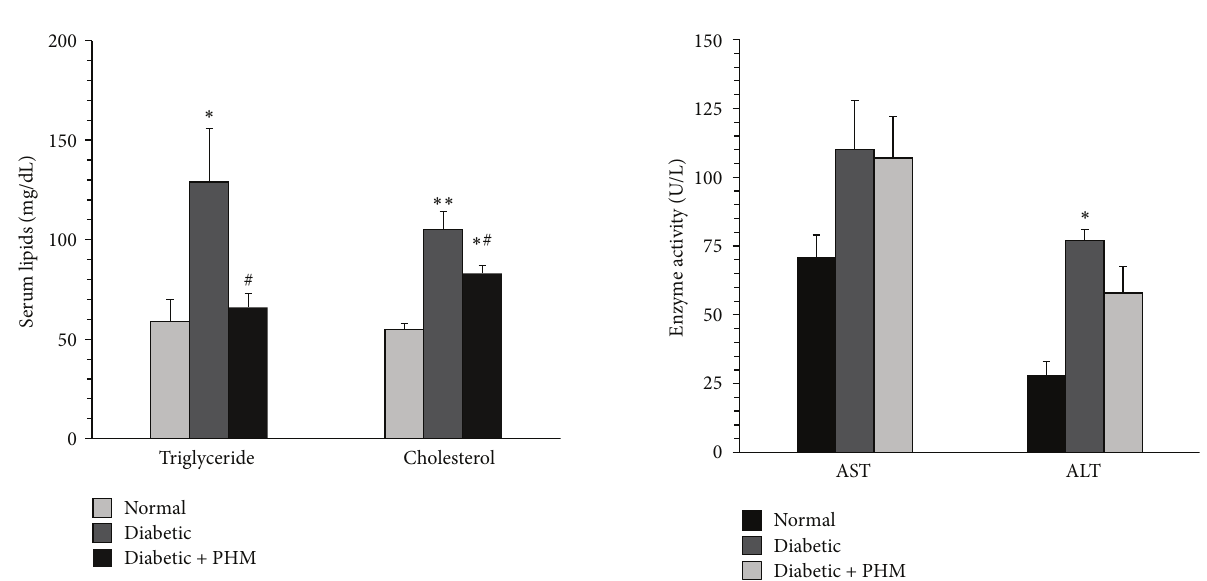
Figure 3: Effects of the polyherbal mixture (PHM) on serum aspartate aminotransferase (AST) and alanine aminotransferase (ALT) activities. The animals in group of diabetic + PHM received PHMfor4weeks. ∗ 𝑃 < 0.05 versusnormalcontrolrats.Thedataare expressed as mean ± SEM for eight (diabetic + PHM) or six (normal and diabetic control)